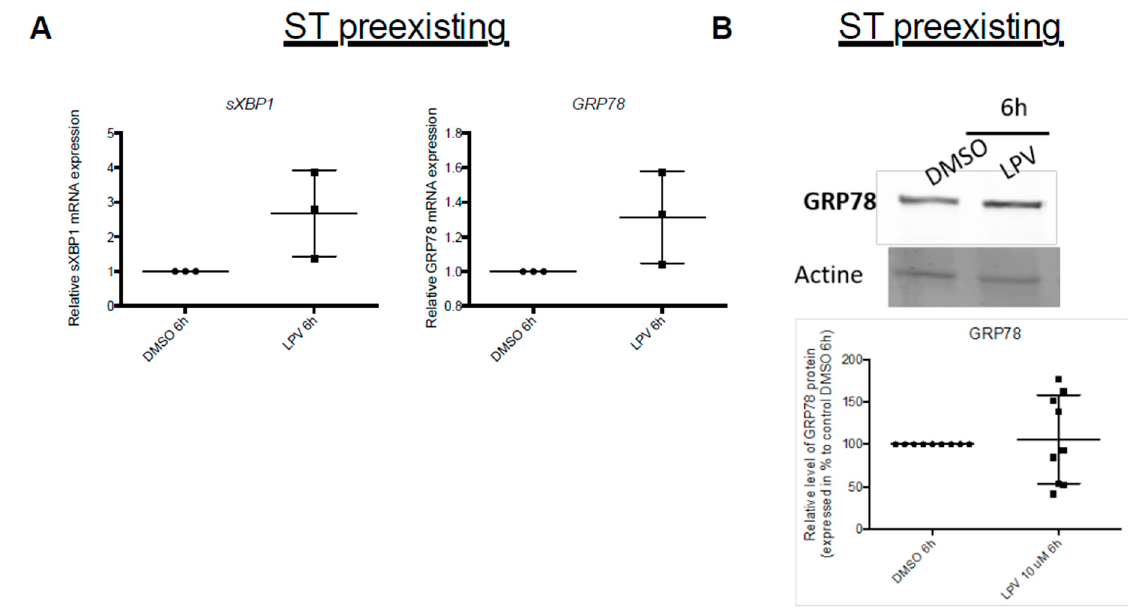
Figure 12. Activation of UPR pathway in VCT cells under LPV exposition. Cytotrophoblast cells isolated from human term placentas were cultured for 72 h before incubation with LPV 10 µ M or DMSO for 6 h. ( A ) mRNA expression of sXBP1 and GRP78 were measured by RT-qPCR. The results are expressed as mean +/ − SD of n = 3 independent experiments. Two-tailed paired no parametric t -test were realized. ( B ) GRP78 protein expression was evaluated by immunoblotting with anti-GRP78 antibody. Actin protein determined with anti-actin antibody was used as loading control. The results are expressed as mean +/ − SD of n = 6 independent experiments. Two-tailed paired no parametric t -test were realized.